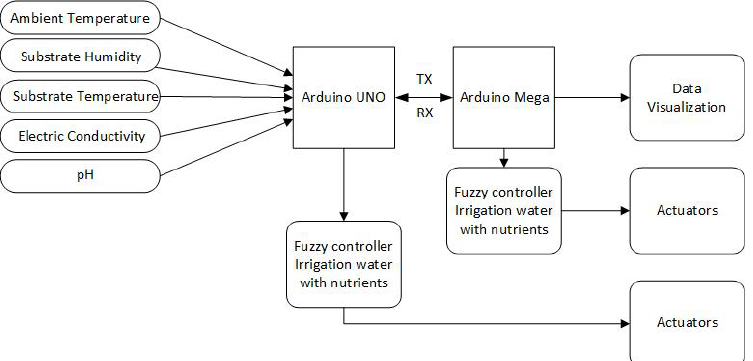
Figure 6. System